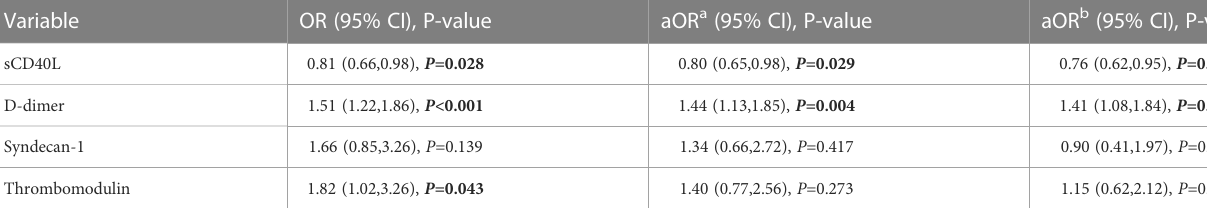
TABLE 3 Associations between AA and the biomarkers as continuous variables.